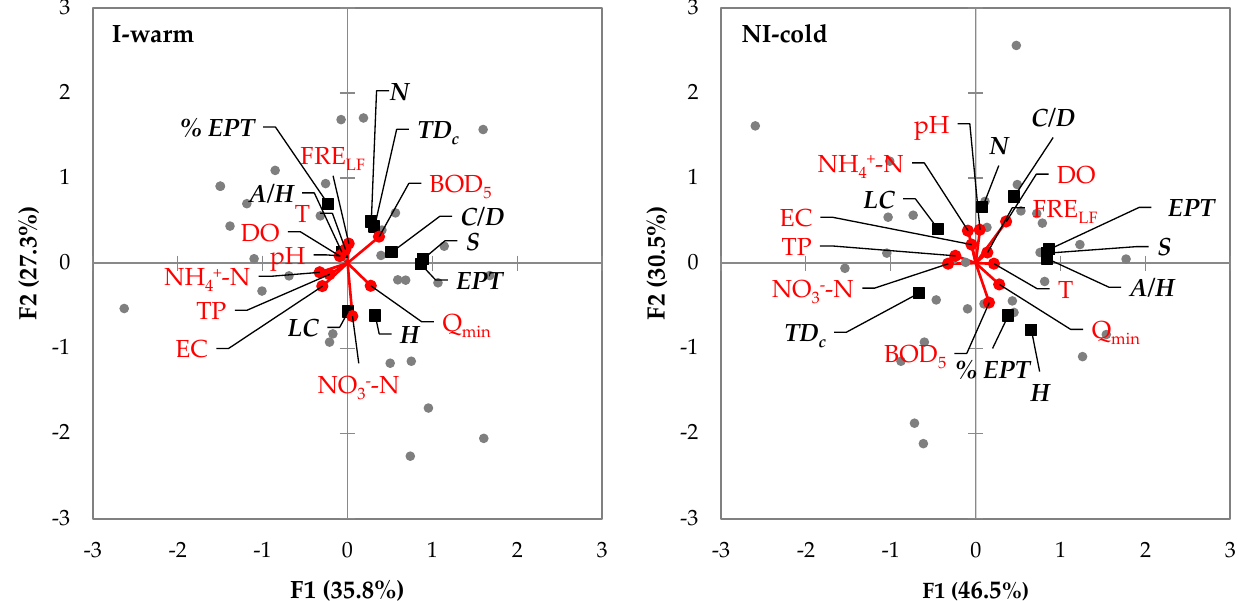
Figure 6. Redundancy analysis (RDA) of the ecological (benthos metrics) and environmental (hydrological and physico-chemical) variables. Only the two hydrological variables mainly contributing to PC1 and PC2 axis of the principal component analysis (PCA) were selected (see Figure S1). I-warm = Irrigation and warm period, NI-cold = Non-Irrigation and cold period. FRE LF = number of low-flow days, Q min = minimum value of flow, T = temperature, DO = dissolved oxygen, EC = electrical conductivity, NH 4+ − N = ammonia nitrogen, NO 3 − − N = nitrate nitrogen, TP = total phosphorus, BOD 5 = biochemical oxygen demand in five days, N = total density of macroinvertebrates, S = family richness, H = Shannon-Wiener diversity index, EPT = richness of EPT taxa , %EPT = relative abundance of EPT taxa , C/D = the ratio of Chironomidae/Diptera individuals, A/H = auto/heterotrophy, TD c = top-down control, LC = life cycle.